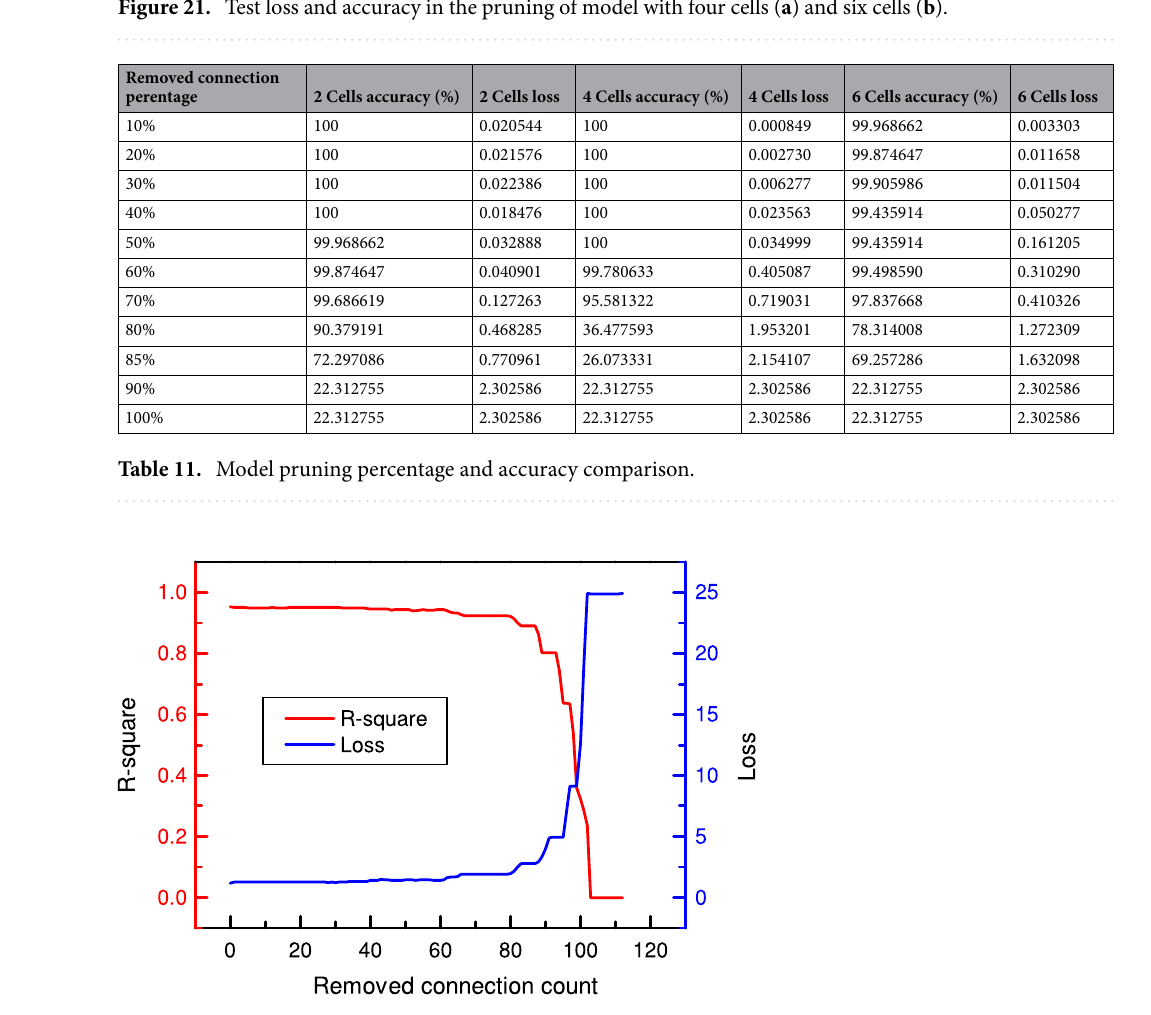
Figure 21. Test loss and accuracy in the pruning of model with four cells ( a ) and six cells ( b ).